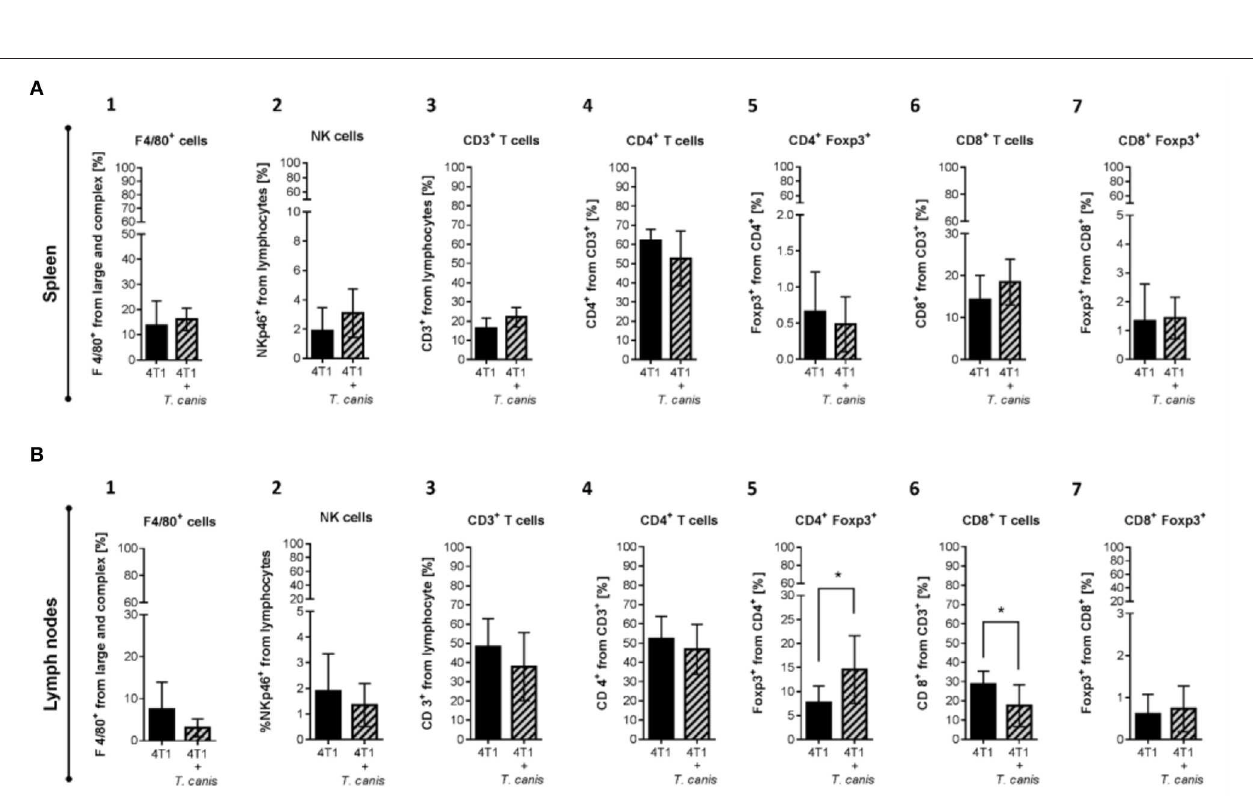
FIGURE 5 | Innate and adaptive immune cells in secondary lymphoid organs. (A) Cells from the spleen: 1. F4/80 + macrophages. 2. NKp46 + cells. 3. T CD3 + . 4. CD4 + T helper lymphocytes. 5. CD4 + /Foxp3 + T lymphocytes. 6. CD8 + T cytotoxic lymphocytes. 7. CD8 + /Foxp3 + T lymphocytes. (B) Immune cells from NLPs: 1. F4/80 + macrophages. 2. NKp46 + cells. 3. T CD3 + . 4. CD4 + T helper lymphocytes. 5. CD4 + /Foxp3 + T lymphocytes. 6. CD8 + T cytotoxic lymphocytes. 7. CD8 + /Foxp3 + T lymphocytes. (B) Graphs represent the mean ± SD of the data from two independent experiments (4T1, n = 10; 4T1 + T. canis , n = 10). Gate from 10,000 cells was collected. Statistical significance was calculated using a t-test (* p ≤ 0.05).